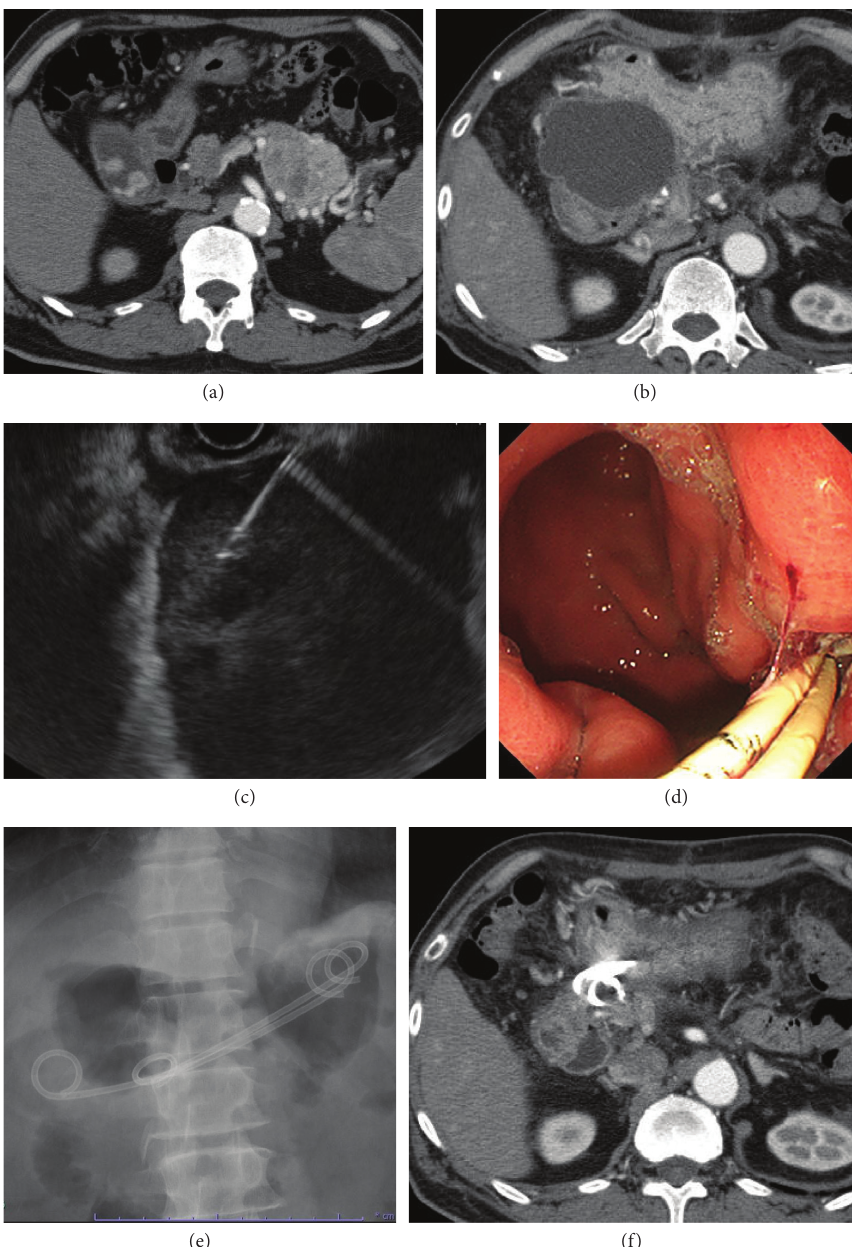
Figure 1: Clinical images of a representative patient who underwent endoscopic ultrasound-guided transluminal drainage (EUS-TD) for postoperative pancreatic fistula (POPF). (a) Preoperative computed tomography (CT) scan reveals a tumor in the pancreatic tail, diagnosed as a pancreatic neuroendocrine tumor. The patient underwent distal pancreatectomy. (b) CTscan performed 14 days after surgery shows an infected POPF of 75 mm diameter. (c) EUS imaging performed on day 15 after surgery shows peripancreatic fluid collection, into which a 19G needle is inserted via a transgastric route. (d) and (e) Two double-pigtailed plastic stents were inserted and can be observed on endoscopic imaging (d) and under fluoroscopic (e) guidance. (f) CTscan performed 2 weeks after EUS-TD reveals resolution of the